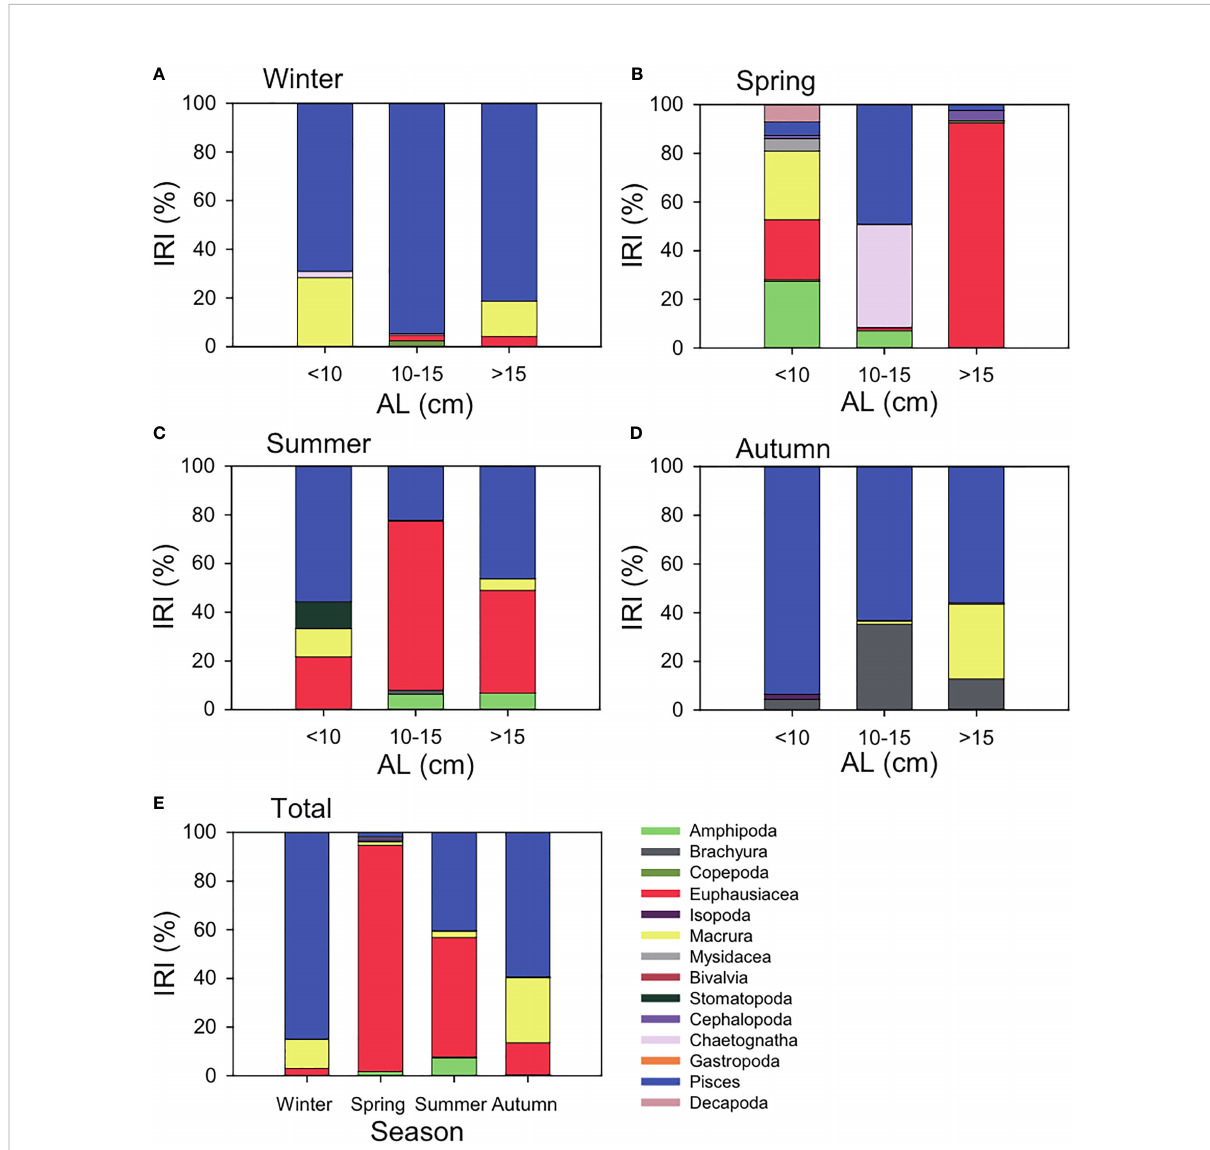
FIGURE 2 Size-related (anal length, AL; 10 cm, 10 – 15 cm, and > 15 cm) and total (E) compositions of the stomach contents of large-head hairtail ( Trichiurus japonicus ) by the index of relative importance (%IRI) expressed as a percentage of the sum of the IRI values in the South Sea of Korea during winter ( A , February), spring ( B , May), summer ( C , August), and autumn ( D , November) 2021.